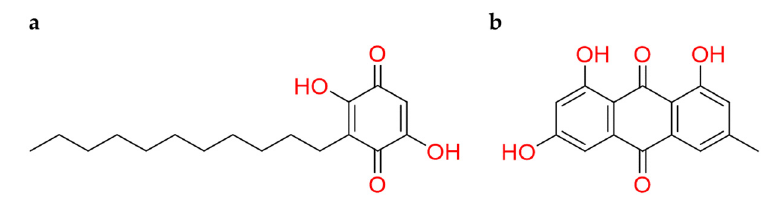
Figure 18. 2D structures of ( a ) embelin and ( b ) emodin.